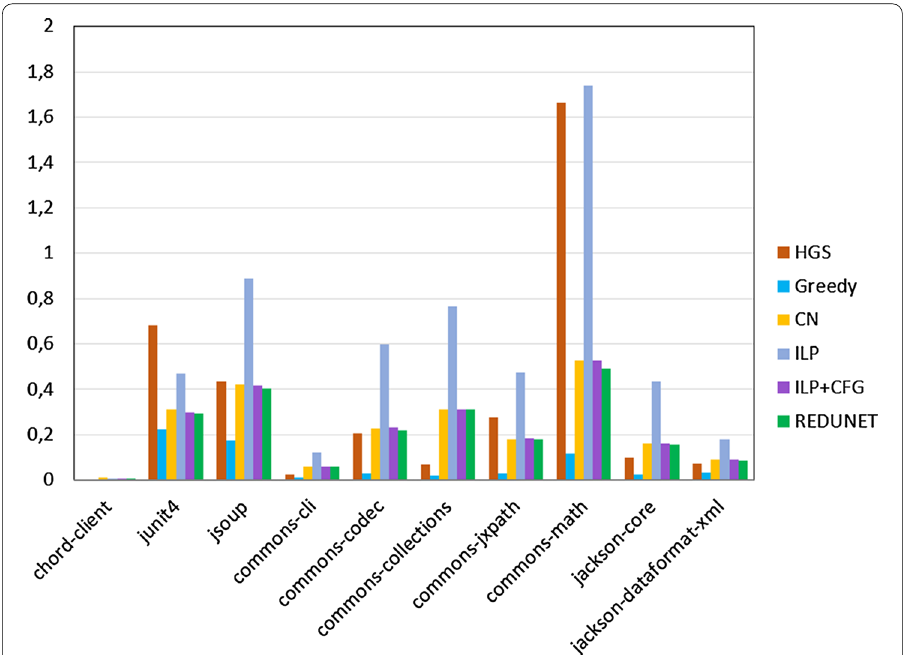
Fig. 7 Efficiency of test suite optimisation Running time in seconds for computing the test suite optimisation ( y -axes). The labels in the x -axis represent the ten software projects under analysis, whose details are reported in Table 2. The series represents the approaches under comparison, whose details are given in Table